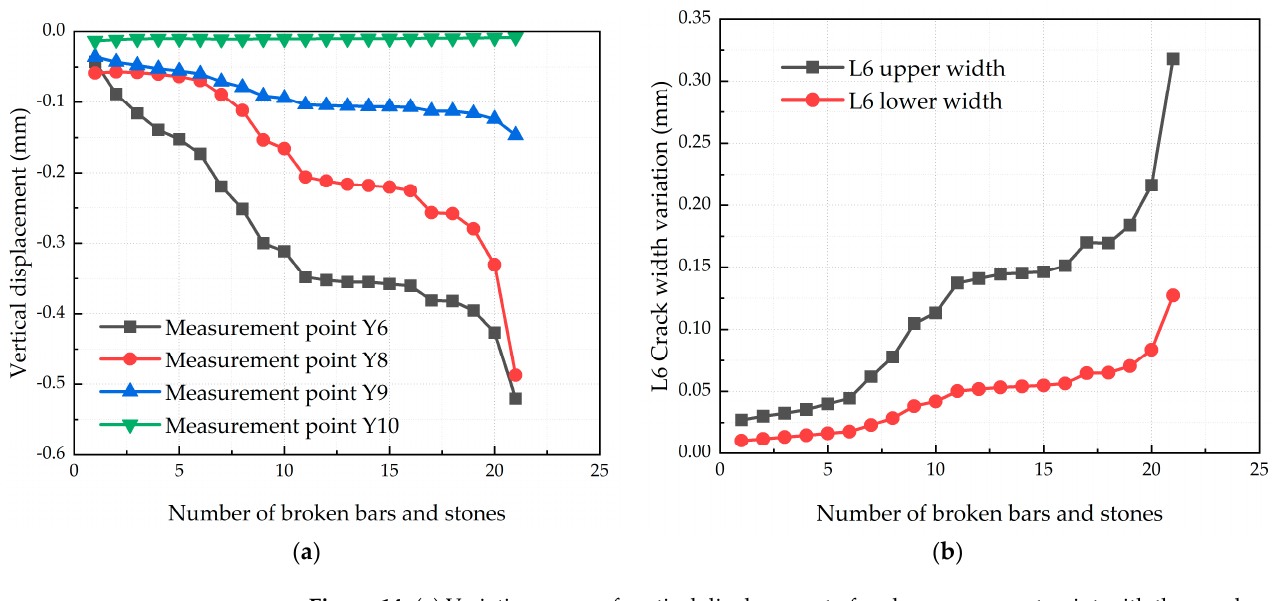
Figure 14. ( a ) Variation curve of vertical displacement of each measurement point with the number of broken slate blocks; ( b ) variation curve of the increase of L6 crack width with the number of broken slate blocks.